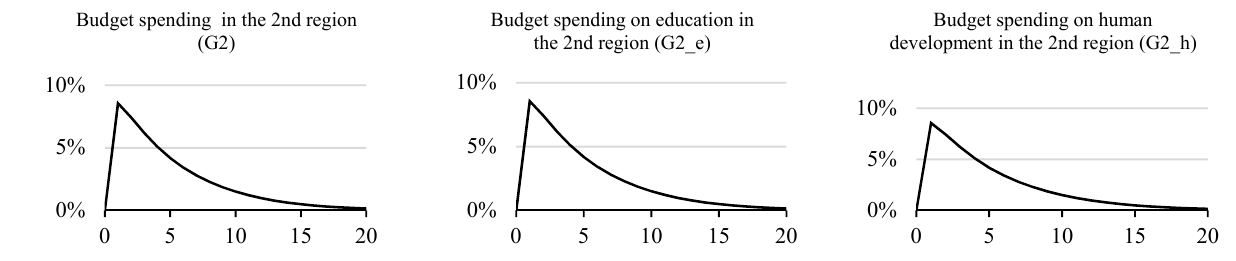
chases and human capital expenditures (Figure 9).